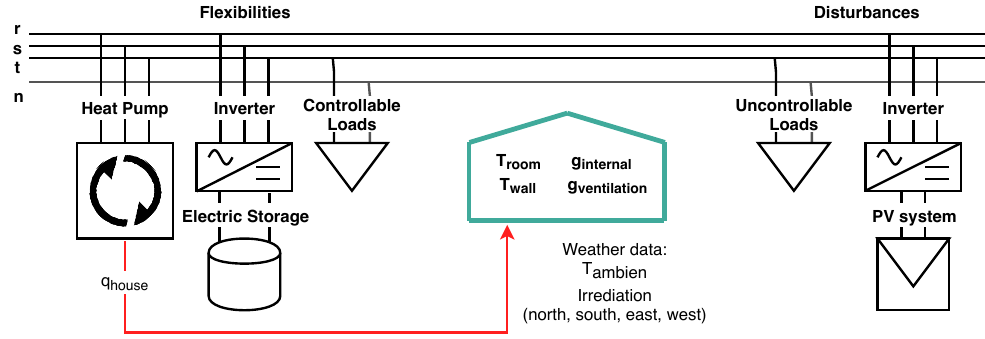
Figure 1. Schematic of three-phase HEMS representing various three-phase interconnections. It can be observed that, heat pump is the only component which connects thermal and electrical